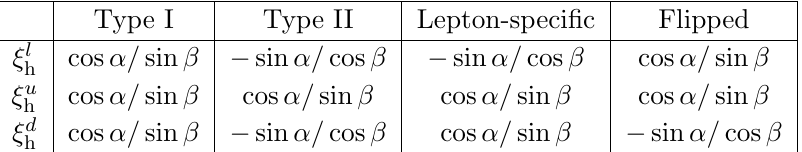
Table 2 . The coupling strengths (cid:24) f of the light, CP-even Higgs boson h to the fermions f relative h to the SM values for di(cid:11)erent types of THDM